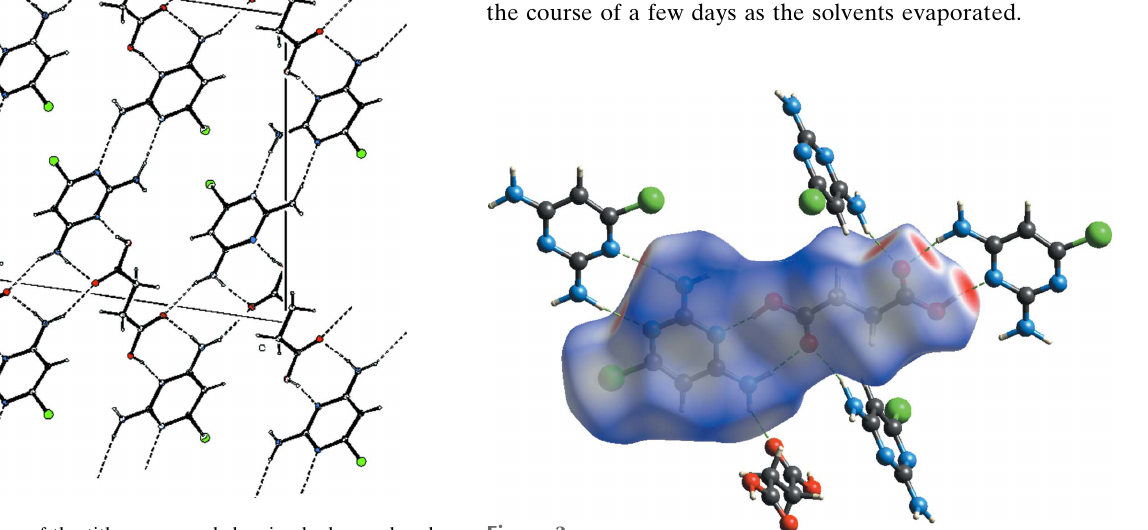
Figure 3 The Hirshfeld surface mapped over d norm for the title compound.